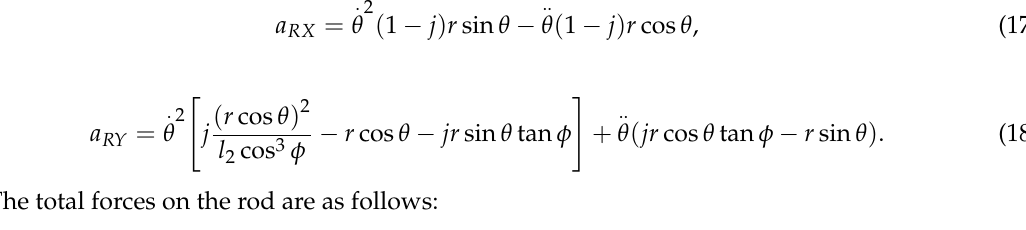
Figure 5. The total forces on the pistons in the test engine.